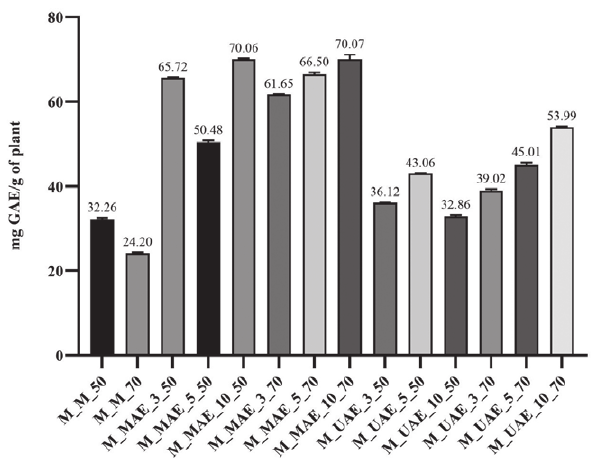
Figure 1. Total polyphenol content of M. officinalis extracts (Data are expressed as mean ±SD values from independent triplicate